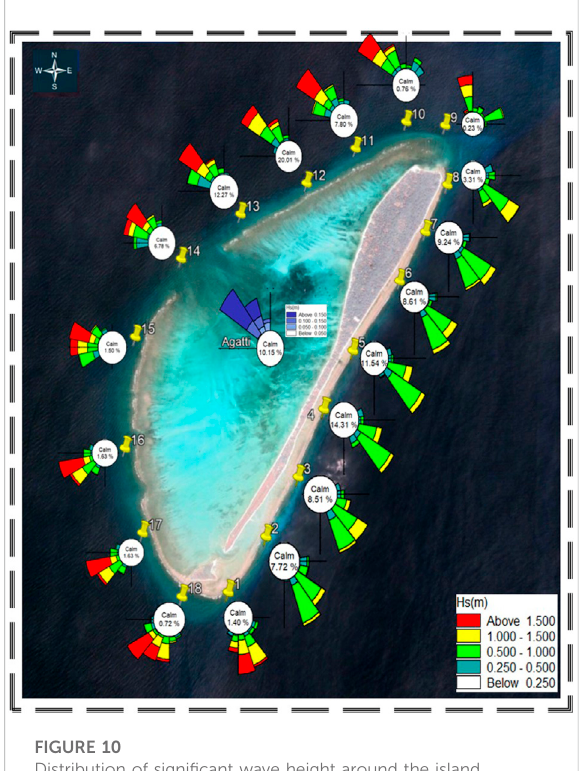
FIGURE 10 Distribution of signi fi cant wave height around the